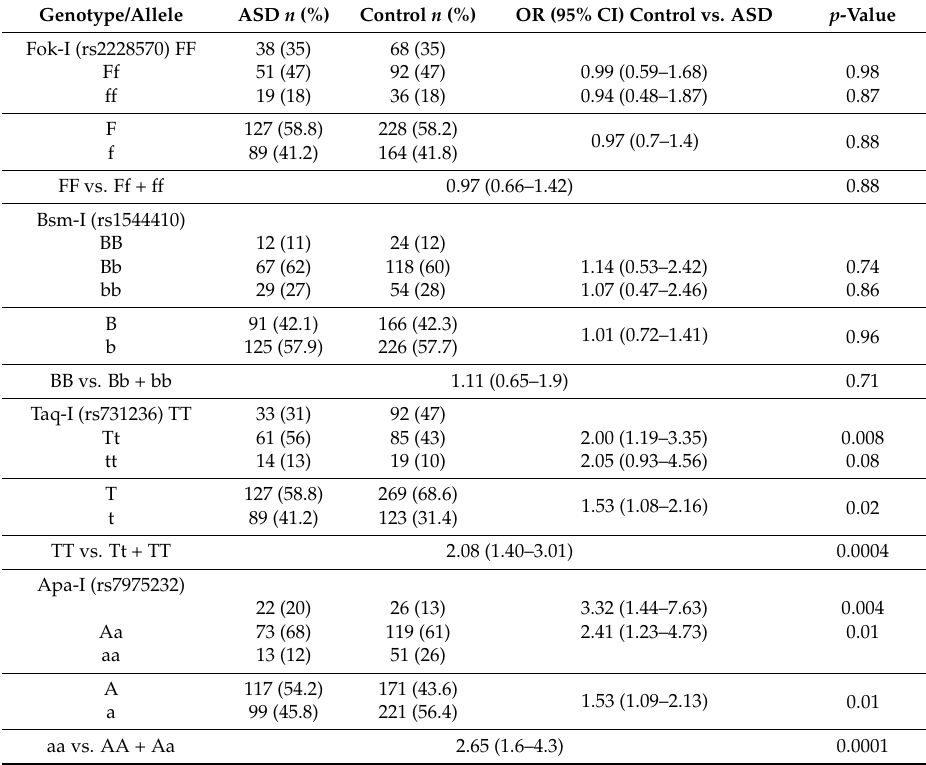
Table 2. Genotype and allele frequencies of VDR SNPs and associations with autism.